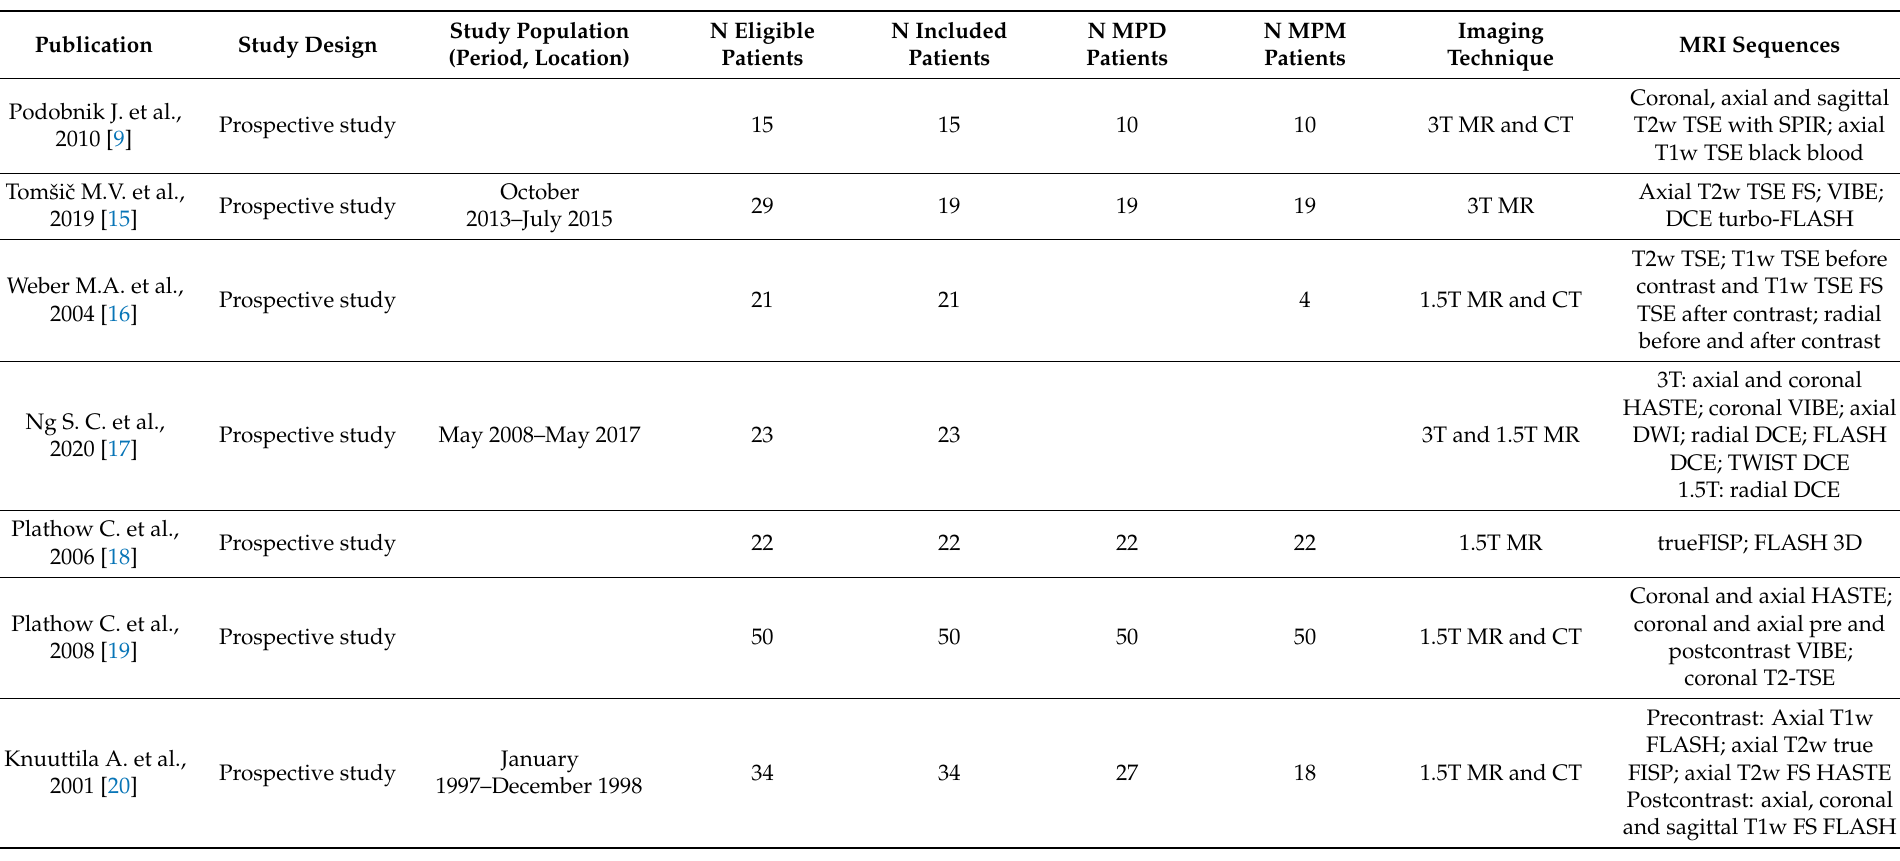
Table 1. Description of studies included. MR: Magnetic Resonance; CT: Computed Tomography; PET: Positron Emission Tomography; T1w: T1-weighted; T2w: T2-weighted; SE: spin-echo; DWI: diffusion weighted imaging; FSE: fast spin-echo; GE: gradient-echo; FS: fat saturation; DCE: dynamic contrast enhancement; SPGR: spoiled gradient recalled; FFE: fast field-echo; TSE: turbo spin-echo. SS-TSE: single shot turbo spin-echo. HASTE: half-Fourier acquired single-shot turbo spin-echo; VIBE: Volumetric interpolated breath-hold examination; FLASH: Fast low angle shot; SPIR: spectral pre-saturation with inversion recovery; TWIST: time-resolved with interleaved stochastic trajectories; FISP: fast imaging with steady-state